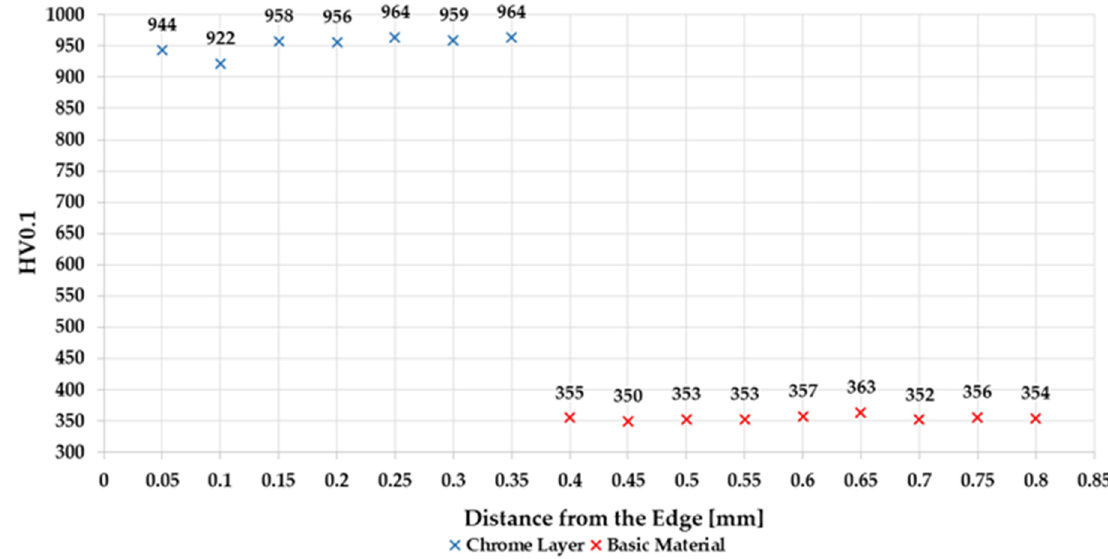
Figure 5. The course of microhardness in sample 0.